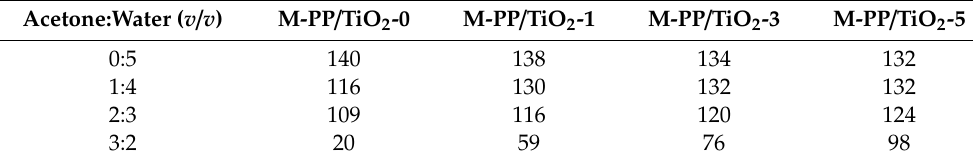
Figure 5. ( a ) Contact angle of M-PP / TiO 2 (m:n represent acetone / water ( v / v )); ( b ) the oil and water drip on the melt-blown membrane (the red circle is kerosene, blue drop is water), and ( c ) the surface tension of different acetone solution. Table 5. The contact angle of acetone solution at PP / TiO 2 melt-blown membranes.